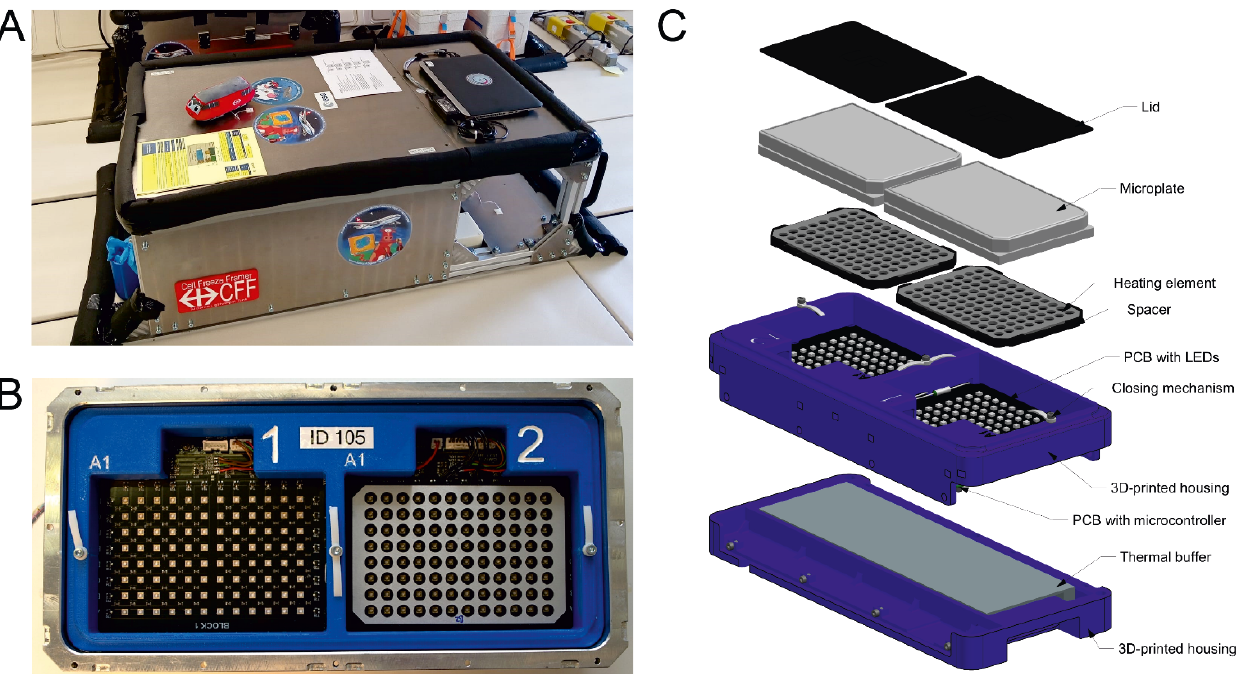
Figure 2. Parabolic flight hardware. ( A ) Flight rack mounted inside Novespace’s aircraft. ( B ) Top view on the functional units, showing the empty payload bays for the two 96 ‐ well plates. The spacer with the heating element was removed in the left bay, exposing the LED array. ( C ) Explosion view of the hardware, highlighting the most relevant elements.